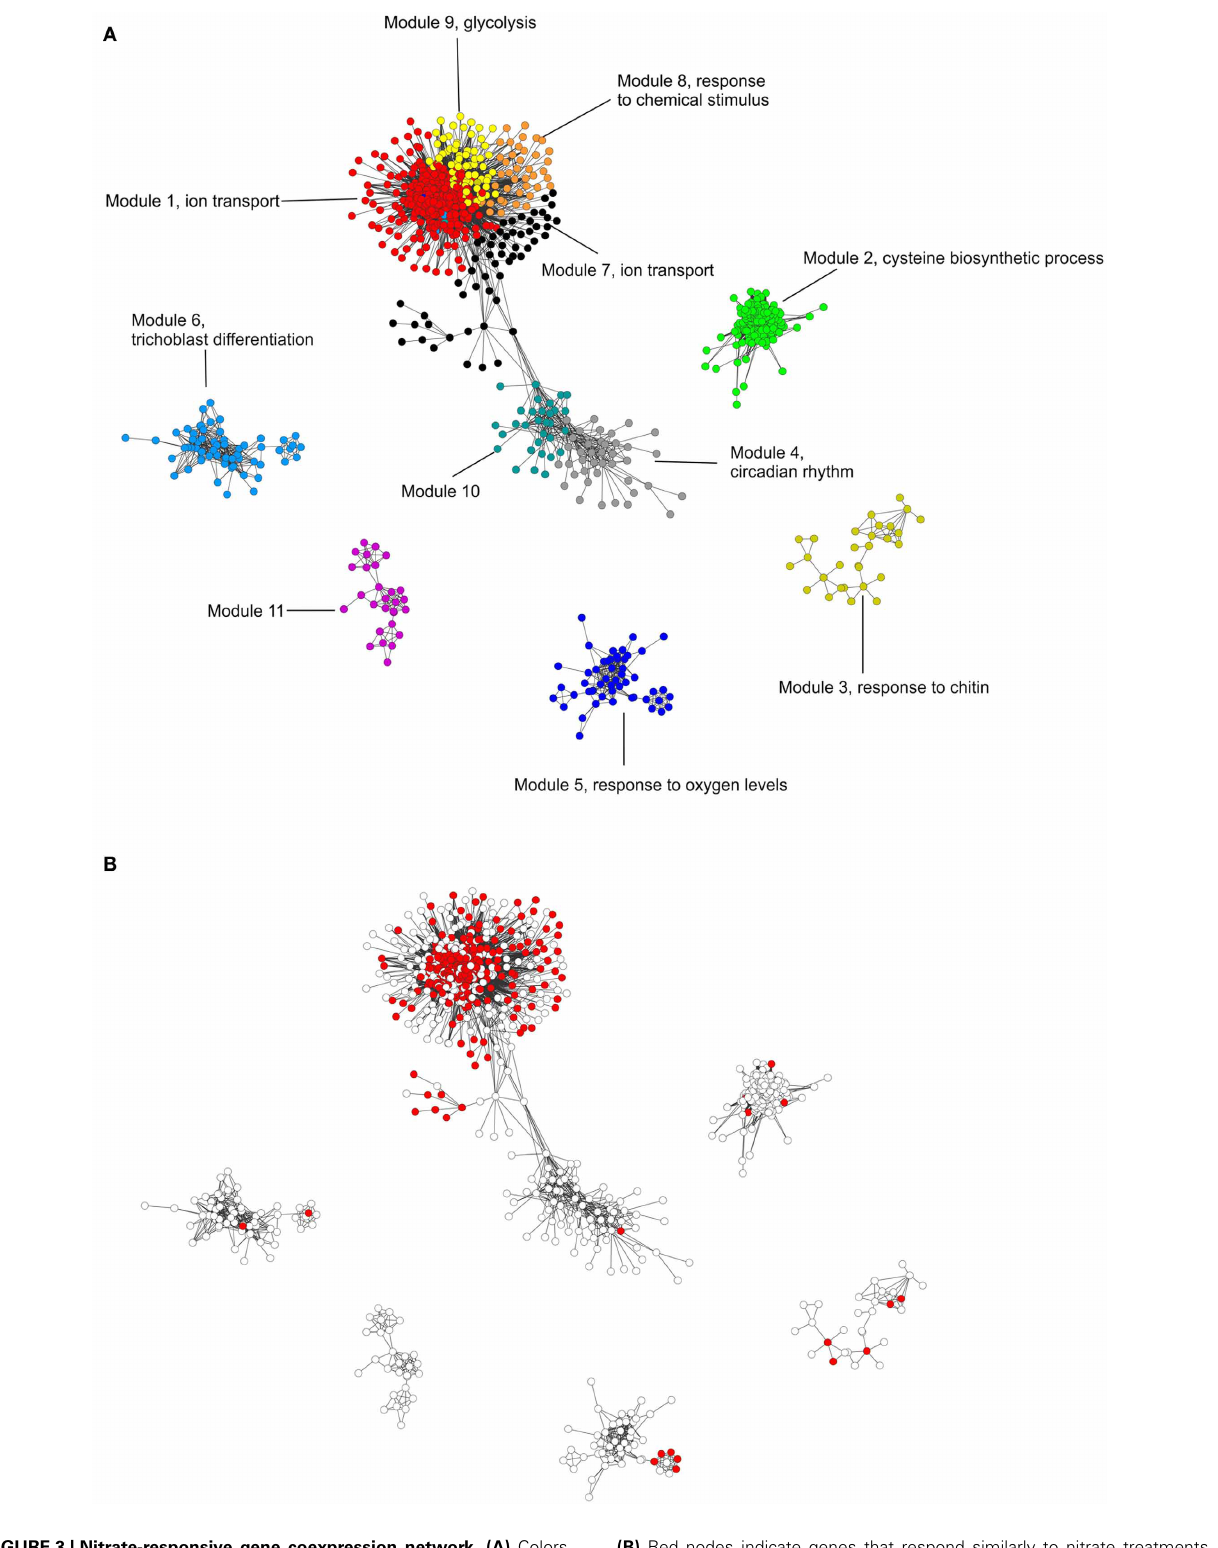
(B) Red nodes indicate genes that respond similarly to nitrate treatments in NR-null mutants and wild-type plants indicating they respond directly to a nitrate signal (Wang et al., 2004). X and Y axes does not represent any particular scale ( Table S3